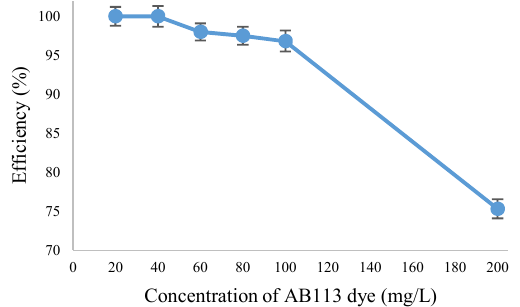
Fig. 8. Effect of initial acid blue 113 dye concentration on dye removal efficiency (pH: 3, modified photocatalyst concentration: 100 mg/l, reaction time: 30